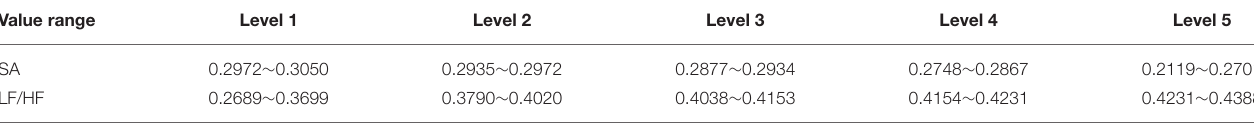
TABLE 4 | The value range of evaluation